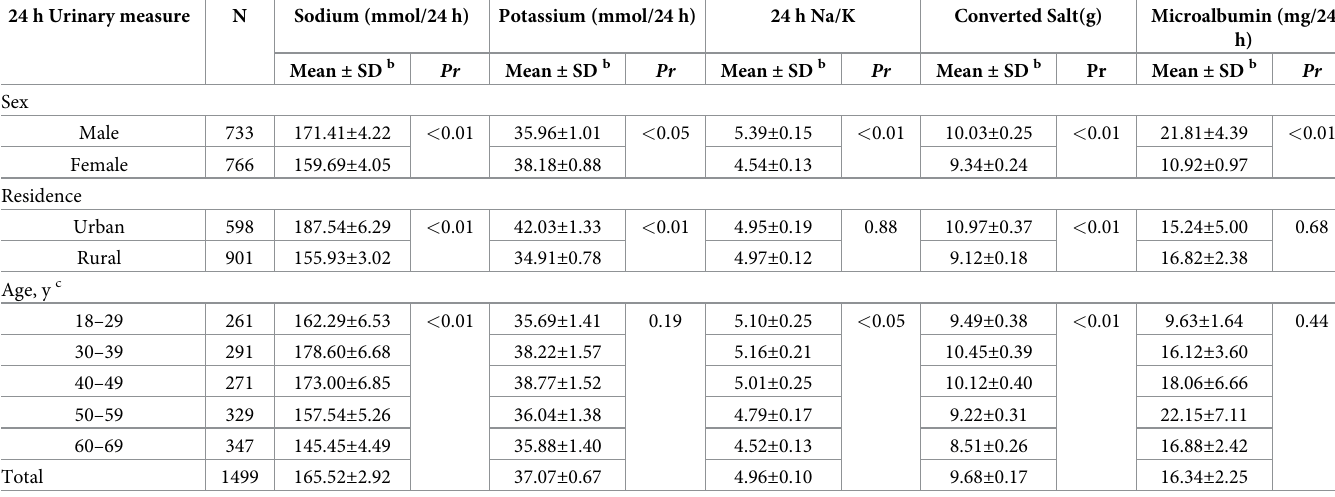
Table 3. 24 h urinary sodium, potassium and microalbumin excretion in different populations of Zhejiang Province of China in 2017 a .